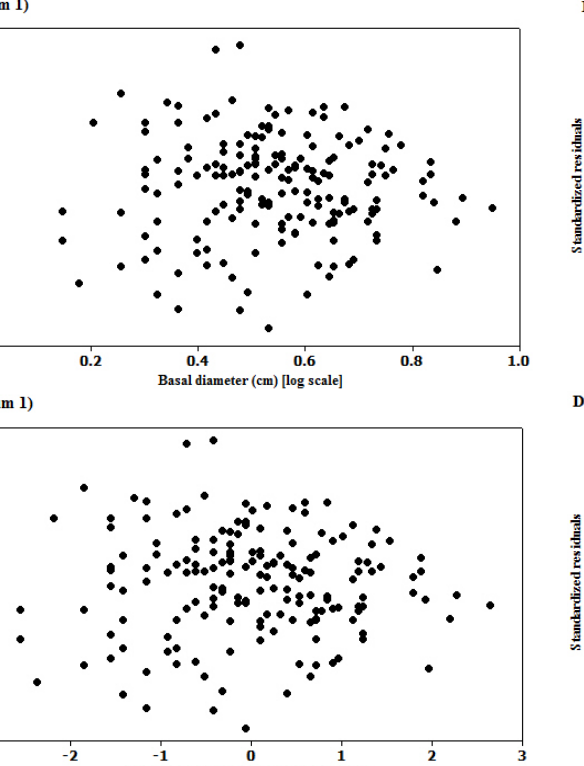
Figure 2. Testing for adequacy of the model on three important assumptions of using linear regression. A and B = testing for linearity; C and D = testing for homoscedasticity; and E and F = testing for